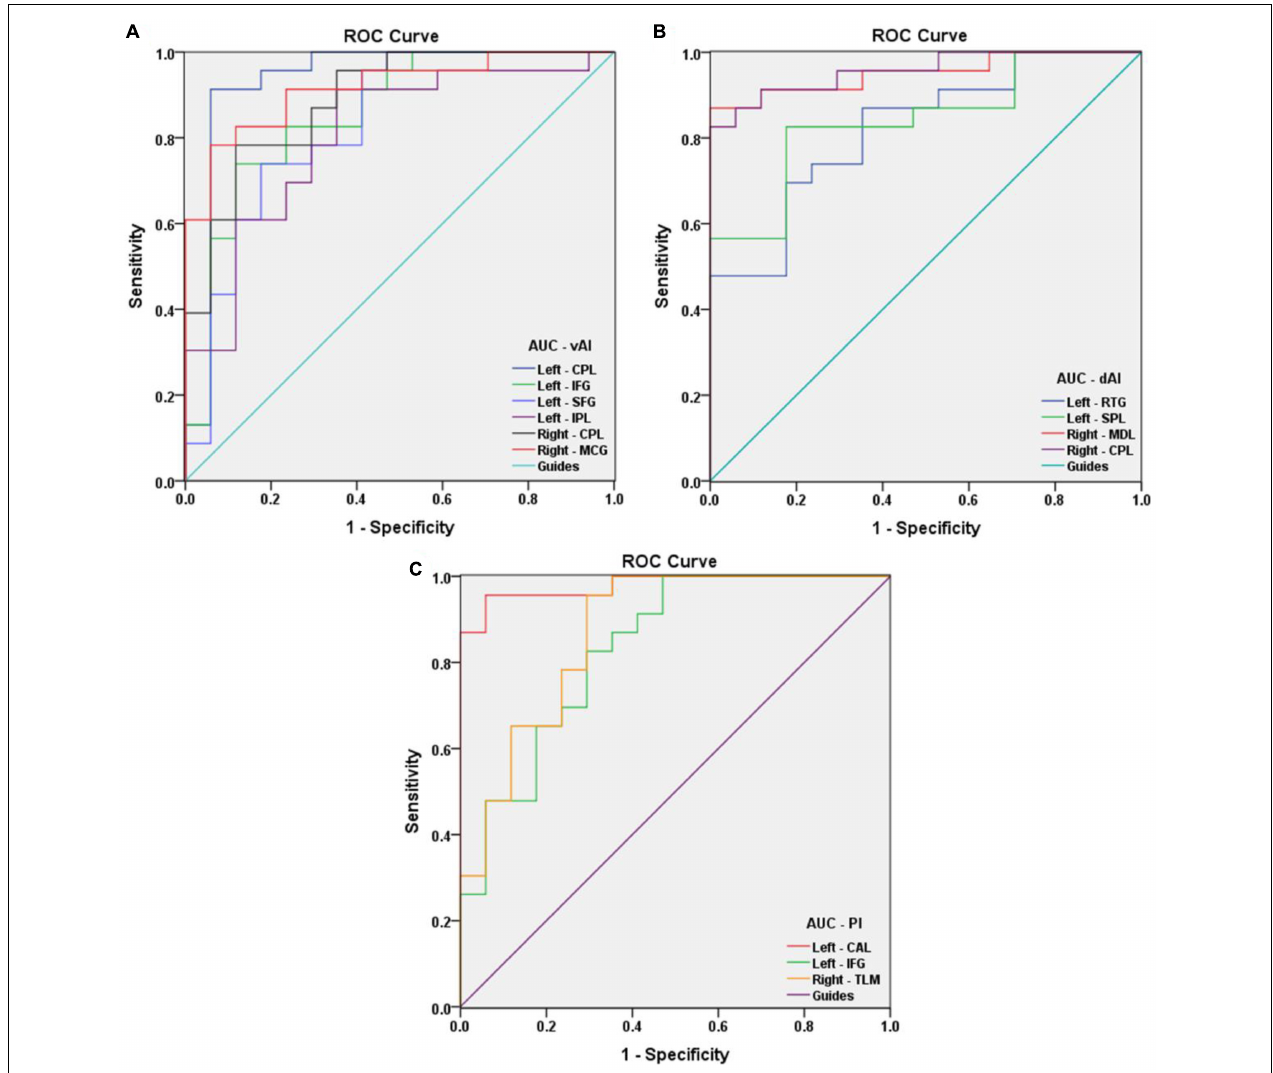
FIGURE 4 | Receiver operating characteristic curve analysis of the mean FC values for the specific cerebral regions. (A) The area under the ROC curve of FC values were presented as follows: the CPL (0.934, 95% CI: 0.833–1.000), IFG (0.854, 95% CI: 0.730–0.978), SFG (0.831, 95% CI: 0.696–0.966), and IPL (0.806, 95% CI: 0.666–0.945) in left vAI, CPL (0.890, 95% CI: 0.790–0.990) and MCG (0.916, 95% CI: 0.830–1.000) in right vAI. (B) The AUCs of FC values in dAI were as follows: RTG (0.821, 95% CI: 0.693–0.949) and SPL (0.841, 95% CI: 0.719–0.964) in left dAI, MDL (0.951, 95% CI: 0.886–1.000) and CPL (0.957, 95% CI: 0.899–1.000) in right dAI. (C) The AUCs of FC values in PI were as follows: CAL (0.980, 95% CI: 0.944–1.000) and IFG (0.834, 95% CI: 0.705–0.962) in left PI, TLM (0.872, 95% CI: 0.758–0.987) in right PI. vAI, ventral anterior insula; dAI, dorsal anterior insula; PI, posterior insula; CPL, cerebellum posterior lobe; IFG, inferior frontal gyrus; SFG, superior frontal gyrus; IPL, inferior parietal lobule; MCG, middle cingulate gyrus; RTG, rectal gyrus; SPL, superior parietal lobule; MDL, medulla; CAL, cerebellum anterior lobe; TLM,